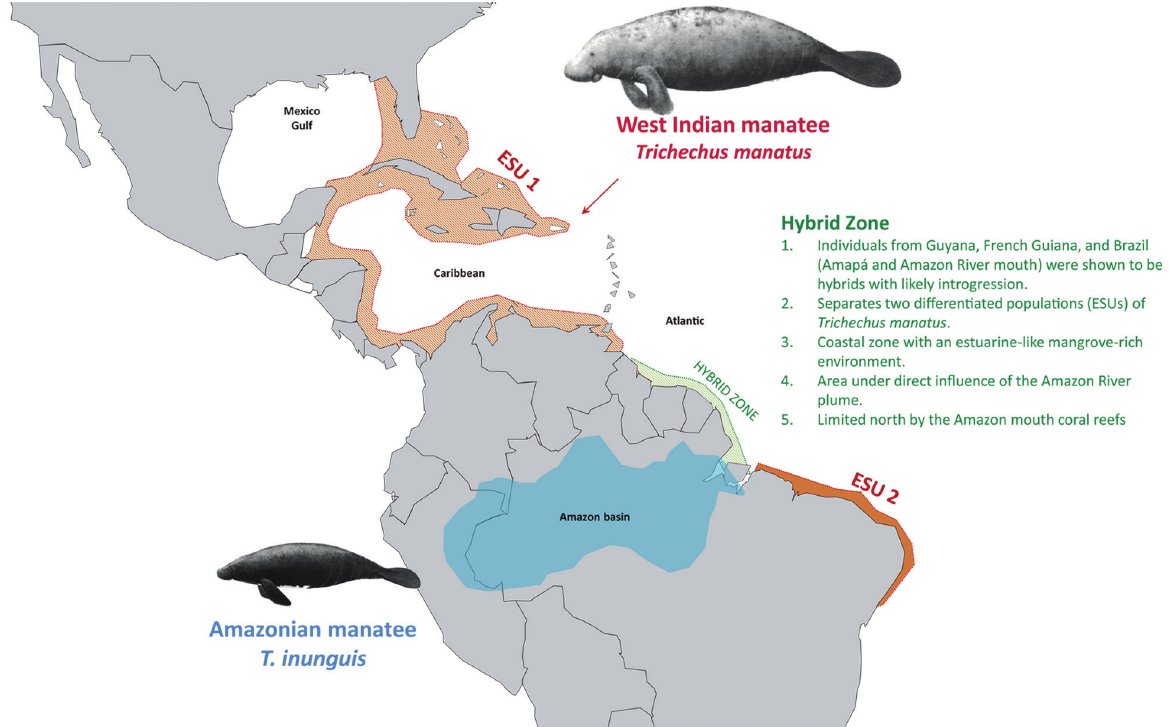
Figure 1 - Map representing the distribution of Trichechus inunguis and T. manatus populations and the interspecific hybrid zone along the guianas Shield coastline. The western and eastern distribution of both T. manatus evolutionary significant units (ESUs) is depicted, according to genetics, cytogenetics and skull morphology evidence (Vianna et al. 2006, Santos et al. 2016, Barros et al.